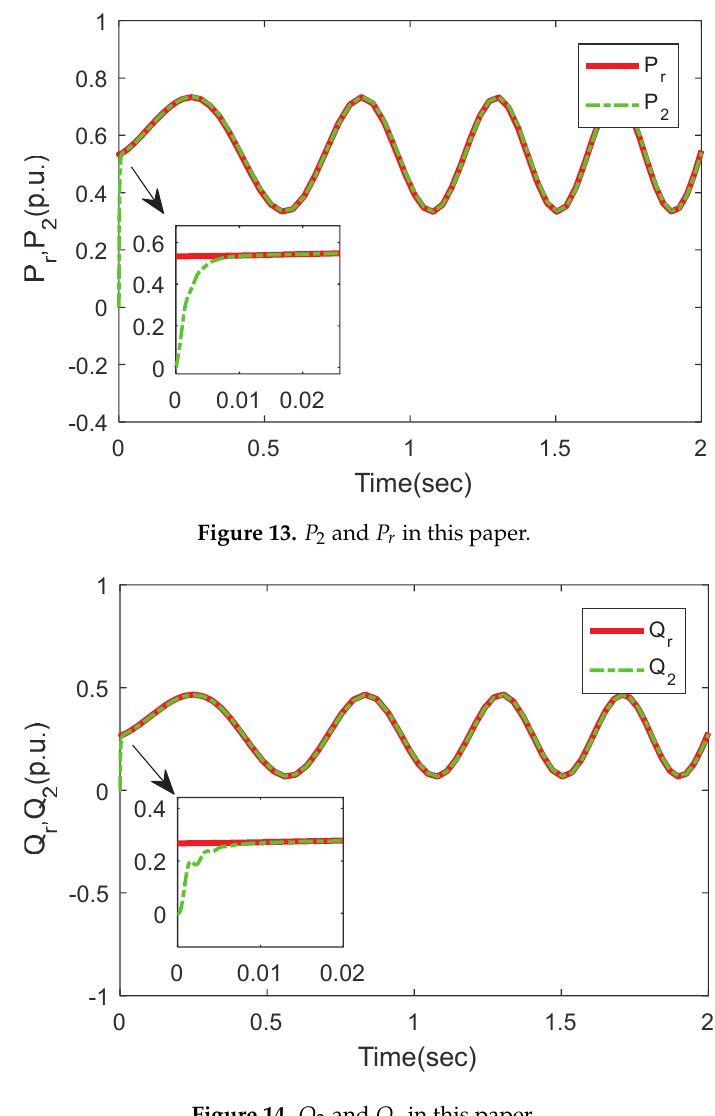
Figure 14. Q 2 and Q r in this